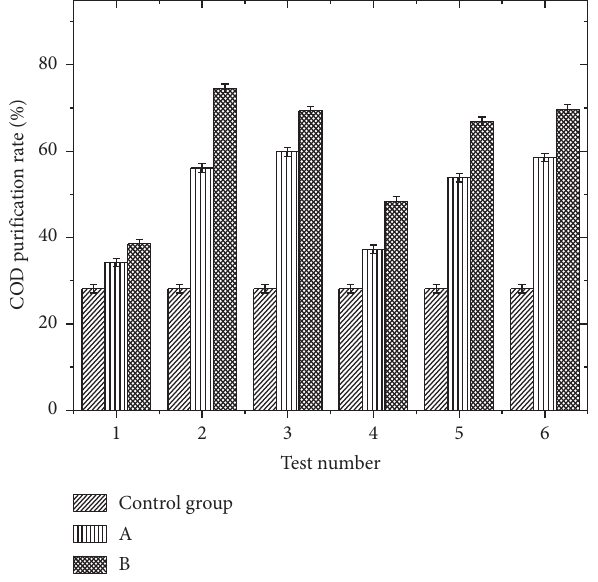
Figure 4: Effective porosity of permeable concrete. Note: A-1 ∼ A-6: permeable concrete specimens with unmodified diatomite and zeolite powder in different dosages; B-1 ∼ B-6: permeable concrete specimen with modified diatomite and zeolite powder in different dosages.